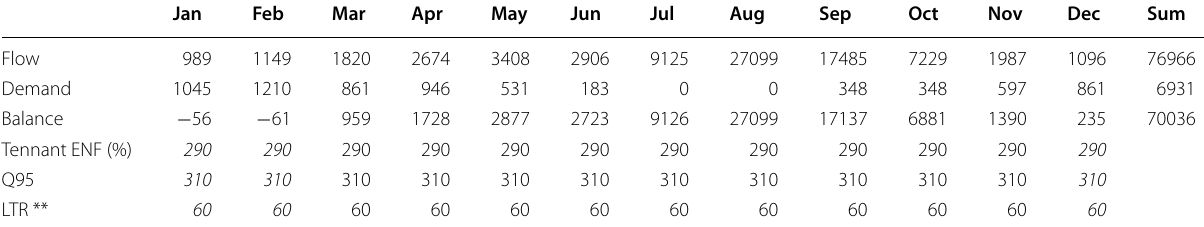
Table 13 The water balance of Arata’s catchment (‘000 m 3 )